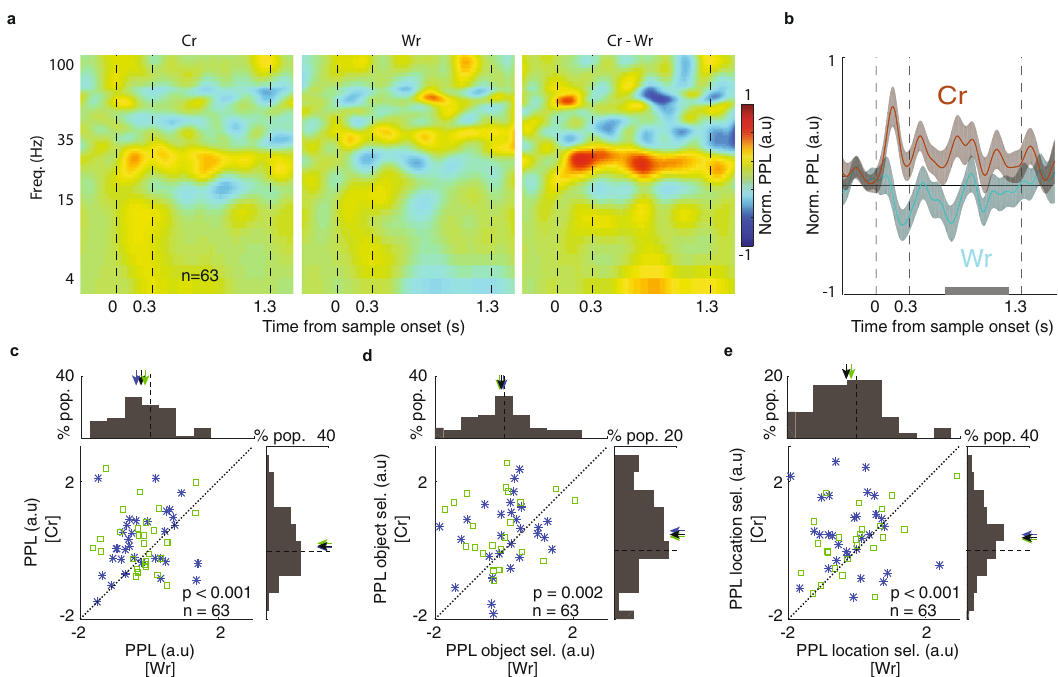
Fig. 2 Inter-areal beta coupling during correct and wrong trials. a PPL between FEF and IT was different for Cr and Wr trials. The time-frequency map of PPL, normalized to baseline across the course of the DMS task for correct (left), wrong (middle), and the difference between Cr and Wr trials (right). b The beta band PPL during sample and delay differed between Cr and Wr trials. Plot shows the average of the beta band PPL (mean ± SEM across recorded pairs) across the course of the DMS task for the correct (brown) and wrong (cyan) trials. Gray bar indicates the analysis window for c – e . c Comparison of the beta band PPL during the delay period for correct versus wrong trials. The beta band PPL was signi fi cantly higher for correct trials ( n = 63 pairs, p = 0.0009, Wilcoxon ’ s signed-rank test, two-sided). M1 plotted in blue and M2 in green. d Comparison of object selectivity of the beta band PPL during the delay period for correct versus wrong trials. Object selectivity of the beta band PPL was signi fi cantly higher for correct trials ( n = 63 pairs, p = 0.0022, Wilcoxon ’ s signed-rank test, two-sided). e Comparison of spatial selectivity of the beta band PPL during the delay period of correct versus wrong trials. Spatial selectivity of the beta band PPL was signi fi cantly higher for correct trials ( n = 63 pairs, p = 0.0004, Wilcoxon ’ s signed-rank test,